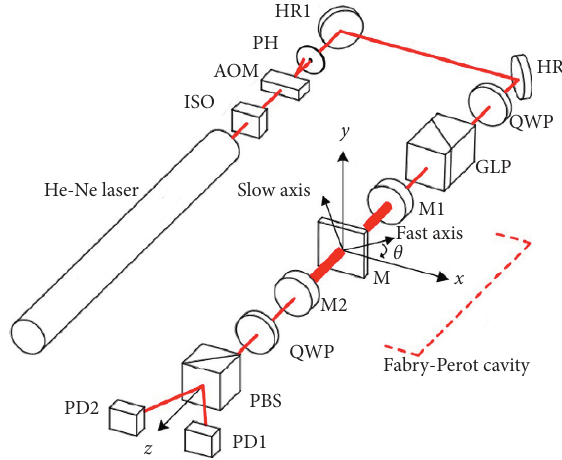
Figure 11: Schematic diagram of birefringence measurement of CRV system